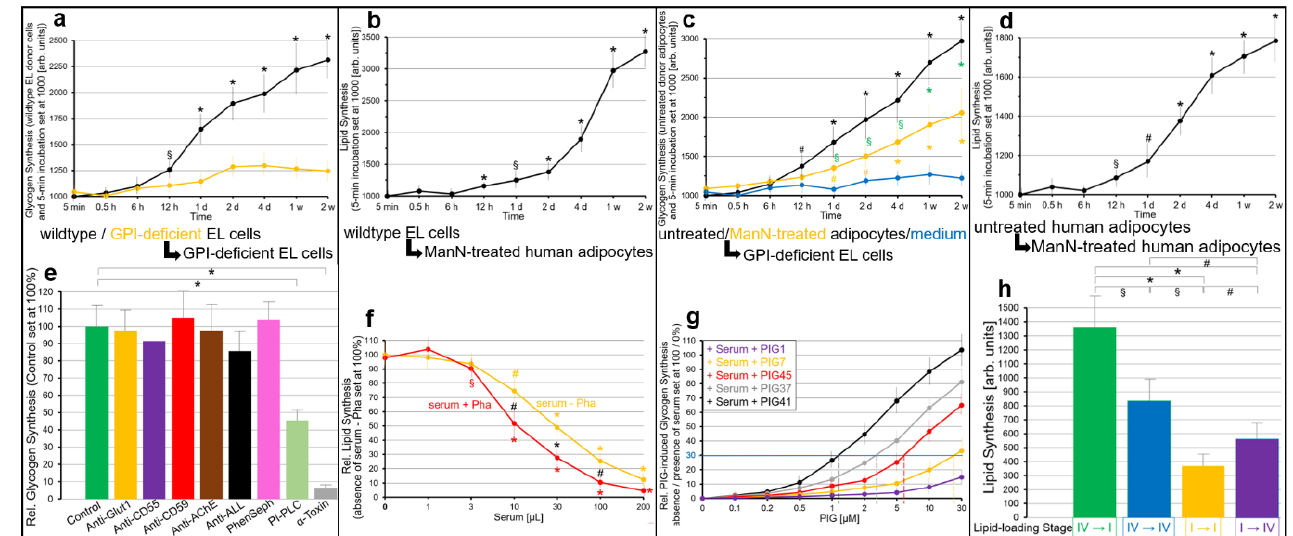
Figure 10. Stimulation of glycogen and lipid synthesis in acceptor cells in transwell co ‐ culture. GPI ‐ deficient EL cells and ManN ‐ treated human adipocytes as acceptor cells in the bottom wells of transwell co ‐ cultures generated above (see Figure 9) were used for determination of glycogen (see legend to Figure 9a,c) and lipid synthesis (see legend to Figure 9b,d), respectively. ( a – d ) The mean values + SD (four to six independent incubations and assays, each) of the synthesized glycogen and lipid are given as arb. units set at 1000 for incubation (5 min) of wildtype donor and GPI ‐ deficient EL acceptor cells ( a ), wildtype EL donor cells and ManN ‐ treated acceptor adipocytes of lipid ‐ loading stage II ( b ), untreated donor adipocytes of stage II and GPI ‐ deficient EL acceptor cells ( c ) or untreated donor and ManN ‐ treated acceptor adipocytes of lipid ‐ loading stage II ( d ). Significant differences vs . 5 ‐ min incubation are indicated (black and orange symbols) for each configuration. Significant differences between untreated and ManN ‐ treated adipocytes as donor cells are indicated ( c , green symbols). ( e , f ) Phase shift Δ for each incubation of acceptor with donor cells was corrected for that with medium alone in the insert wells ( Δ Medium) and used for calculation of the relative glycogen and lipid synthesis with controls (no added agent or serum) set at 100% and significant differences vs. control ( e ) or absence of serum ( f , orange and red symbols) as well as for serum vs. serum + Pha ( f , black symbols) indicated. ( g ) Phase shift Δ were used for calculation of the relative glycogen synthesis with absence and presence of serum set at 100% and 0%, respectively. ( h ) Phase shift Δ were corrected for those with medium alone in the insert wells ( Δ Med.I/IV, Δ Medium for lipid ‐ loading stage I or IV) for all configurations of lipid ‐ loading stages of donor → acceptor adipocytes and used for calculation of lipid synthesis [arb. units]. Significant differences between the four different configurations of lipid ‐ loading stage of donor → acceptor adipocytes are indicated (* p < 0.01, # p < 0.02, § p < 0.05).